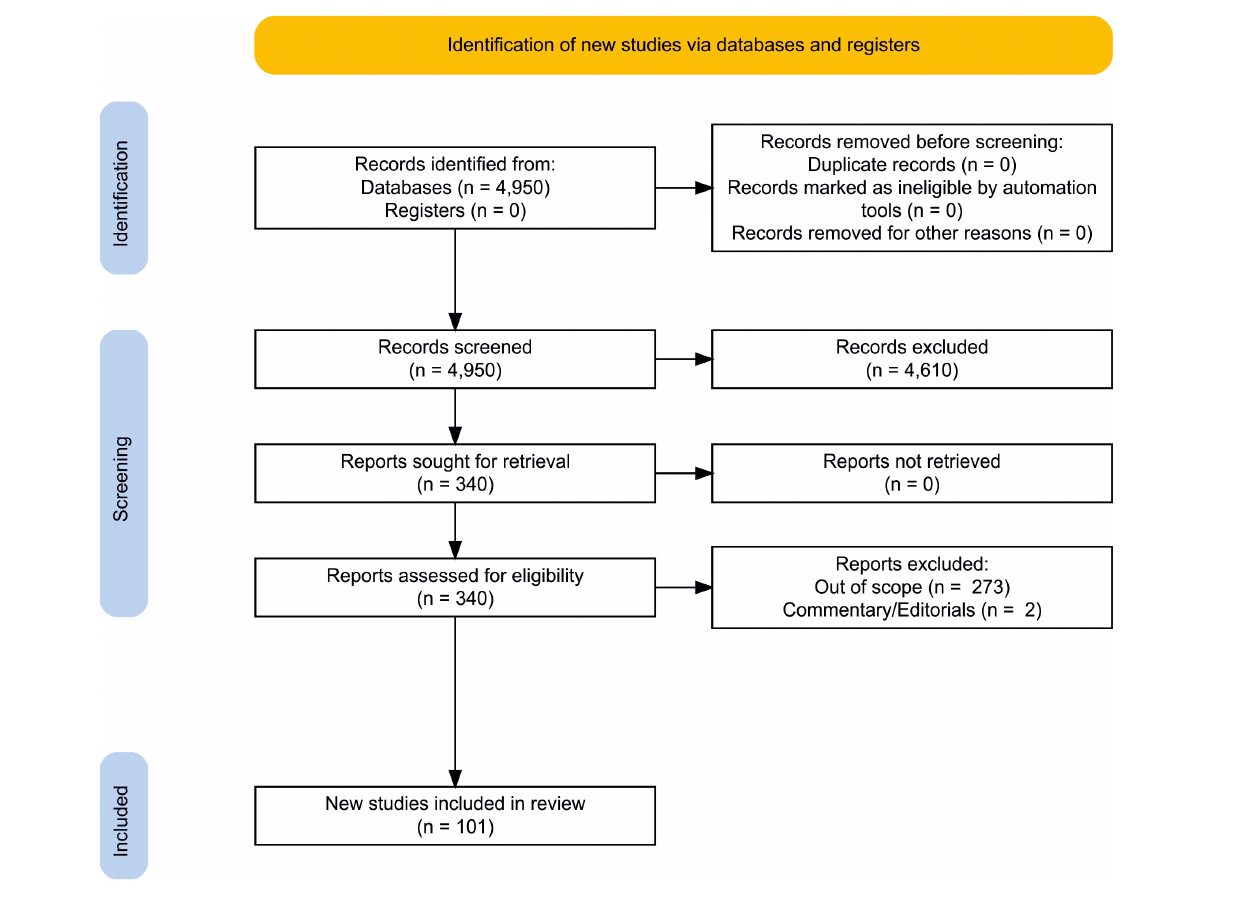
FIGURE 2 | PRISMA 2020 flowchart diagram. Created using an online tool: https://estech.shinyapps.io/prisma_flowdiagram/ (15).